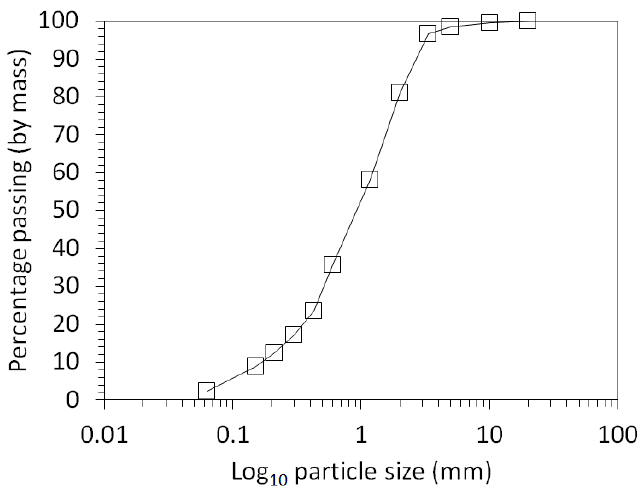
Figure 3. Particle size as a function of percentage passing (by mass) for the composite mine tailing sample.